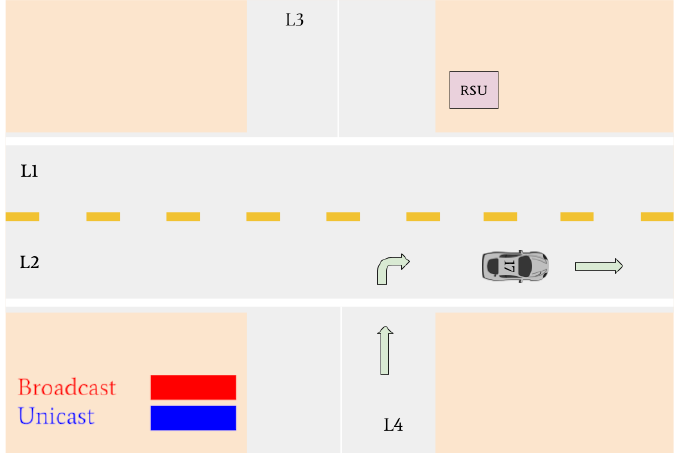
Figure 22. Vehicle 17 is the last remaining vehicle in the intersection and turns right.